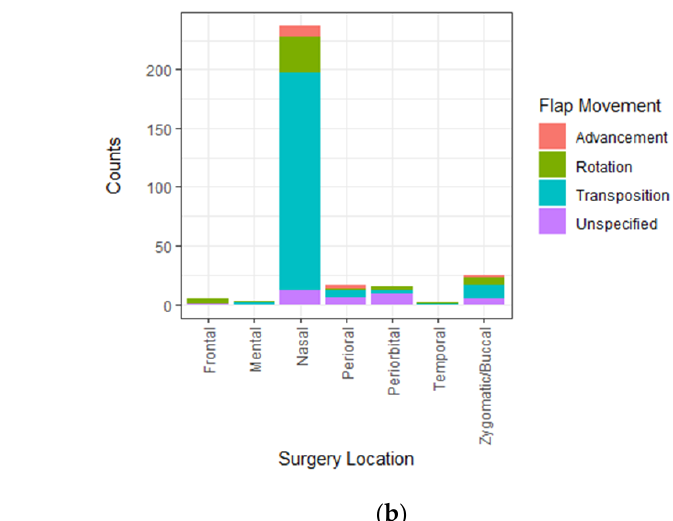
Figure 2. Distribution of flap types and facial regions. ( a ) Distribution of flap types and ( b ) flap design used according to distinct facial region.